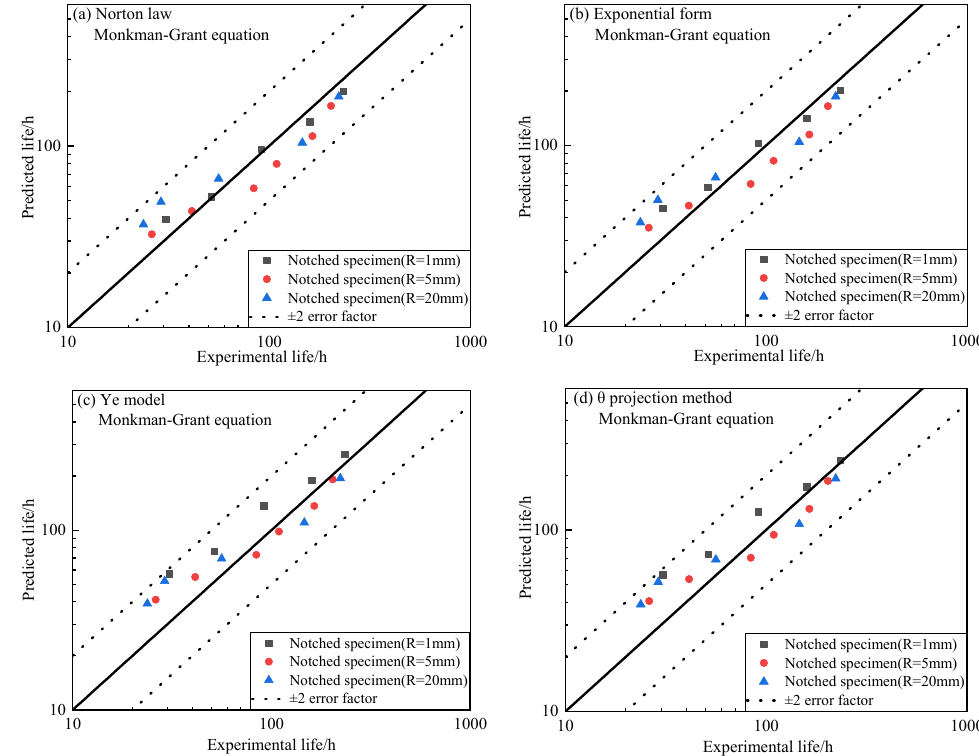
Figure 13. The prediction results are based on different constitutive models and Monkman–Grant equation: ( a ) Norton law; ( b ) Exponential form; ( c ) Ye model; ( d ) θ projection